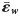
Relative hybrid fitness through time in the analytic model.Results from Eq (2) are shown for three sets of parameters. Heterosis occurs during the first four fixed substitutions with set (A). Parameters values in (A) are ε¯w = 0.02 and ε¯b = 0.01; in (B) are ε¯w = 0.01 and ε¯b = -0.01; and in (C) are ε¯w = 0.05 and ε¯b = -0.01. In all cases the populations are diverging symmetrically (v = 1/4) and epistatic dominance is additive (α1 = 1/4). See S2 Fig for an exploration of a wider range of parameters.